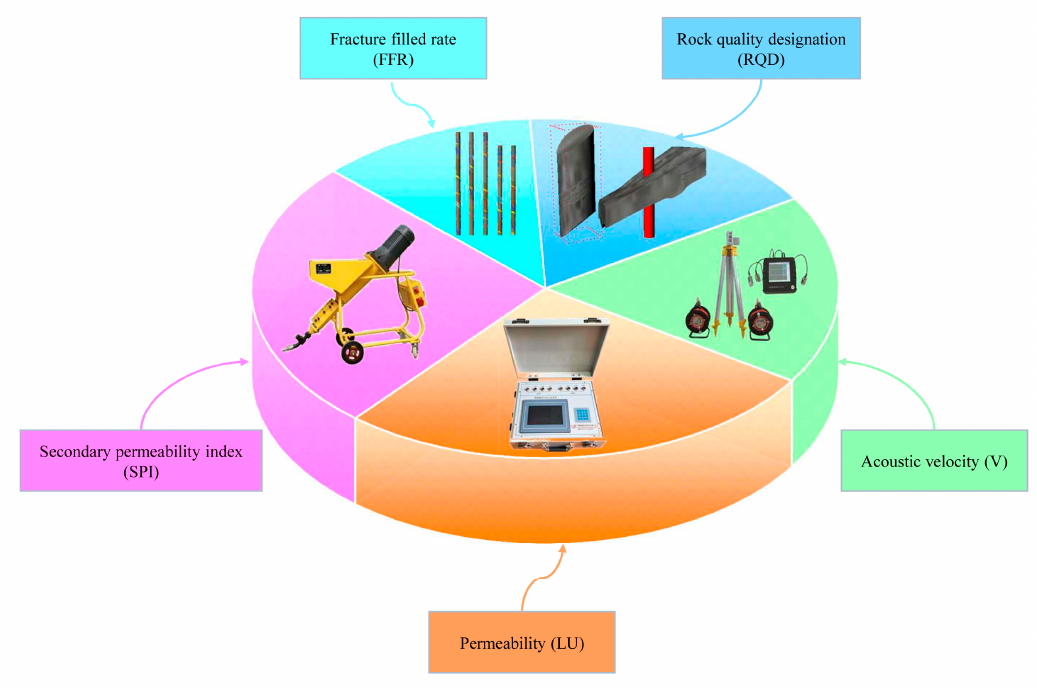
Figure 2. Indicator system for curtain-grouting evaluation.